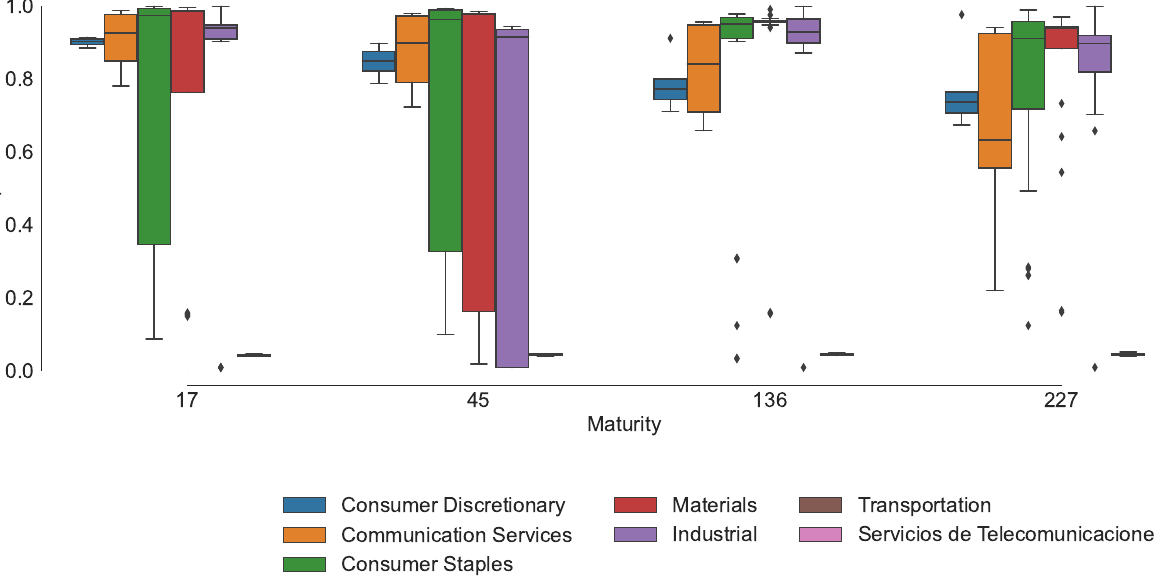
Figure 3. Distribution of the value of α among all five exercise prices for the options by